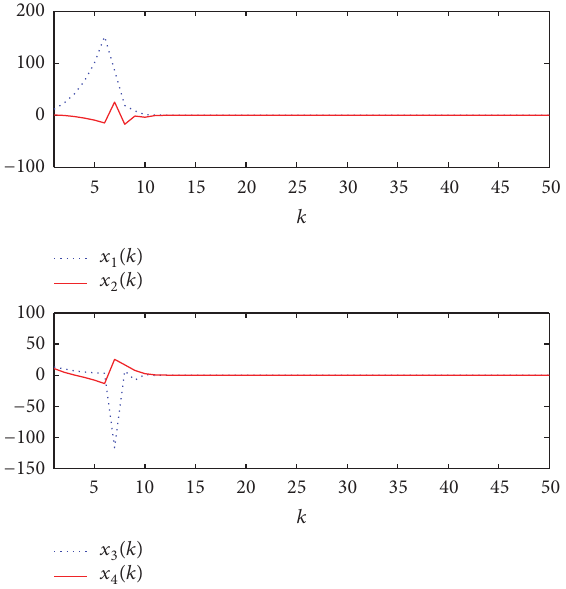
Figure 3: Asymptotic convergence of the system when 𝑁 = 11 under method I.